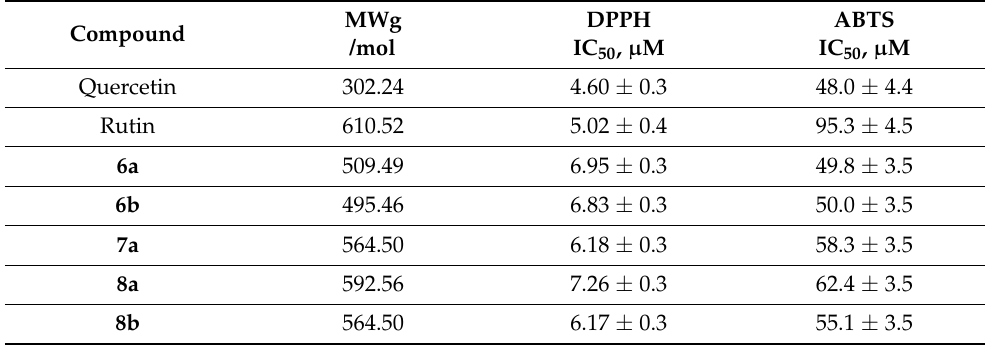
Table 2. Free radical scavenging activities of synthetic derivatives 6–8 a , b , compared with natural antioxidants—quercetin and